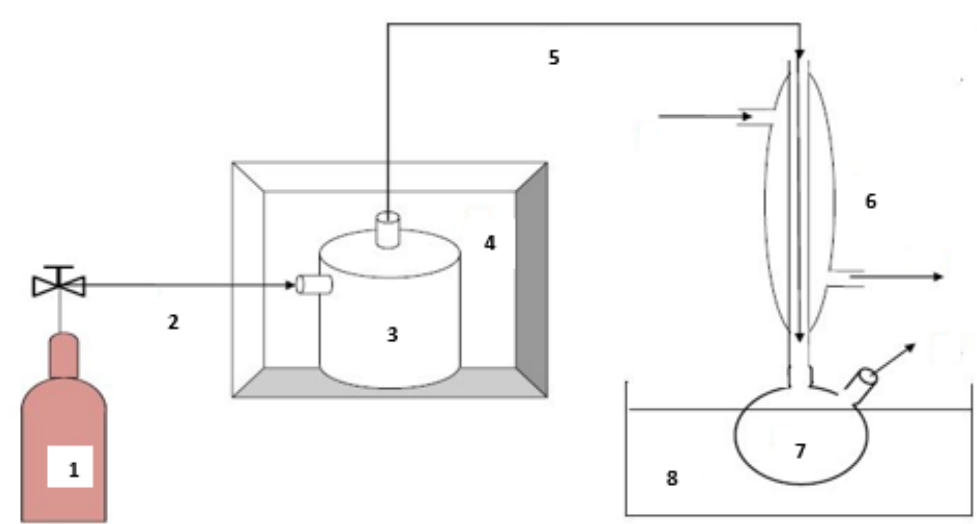
Figure 3. Waste tire pyrolysis schematic [9]: 1—Nitrogen bottle; 2—Nitrogen inlet; 3—Fixed bed reactor; 4—Muffle furnace; 5—Vapor outlet; 6—Reflux condenser; 7—Pyrolytic oil collector; 8—Ice bath.